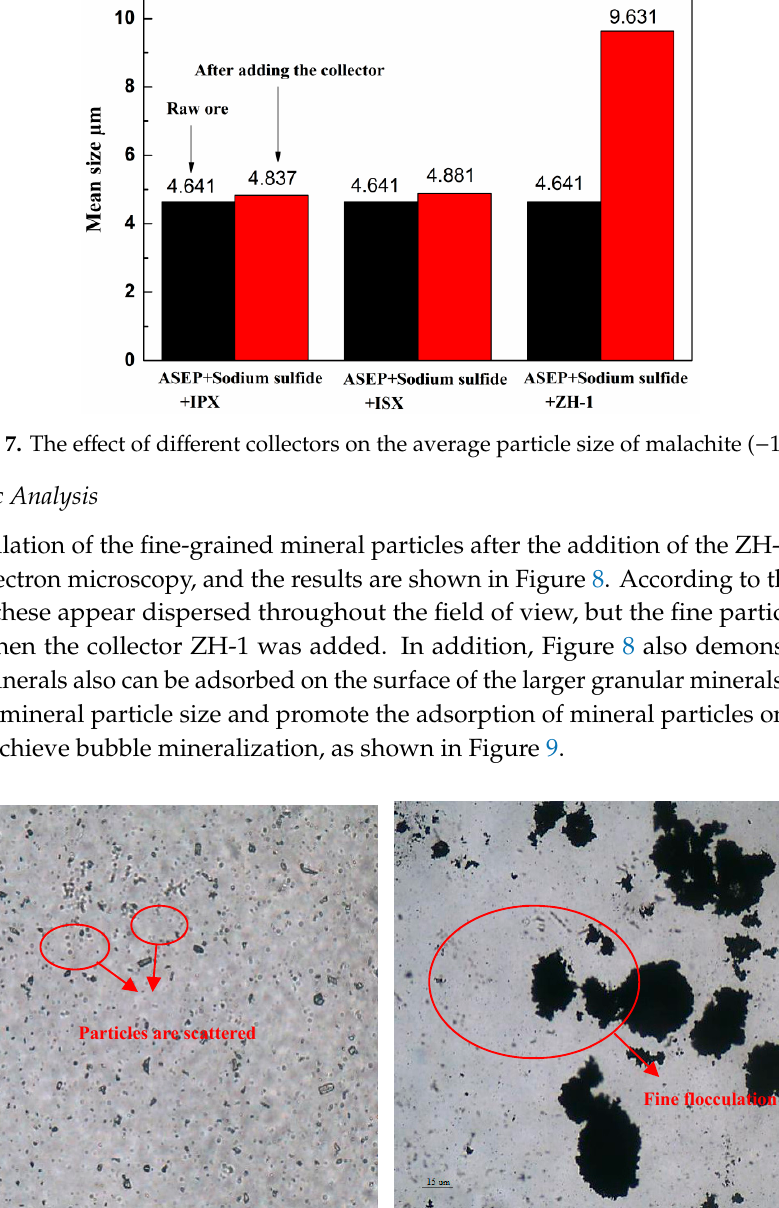
Fine flocculation